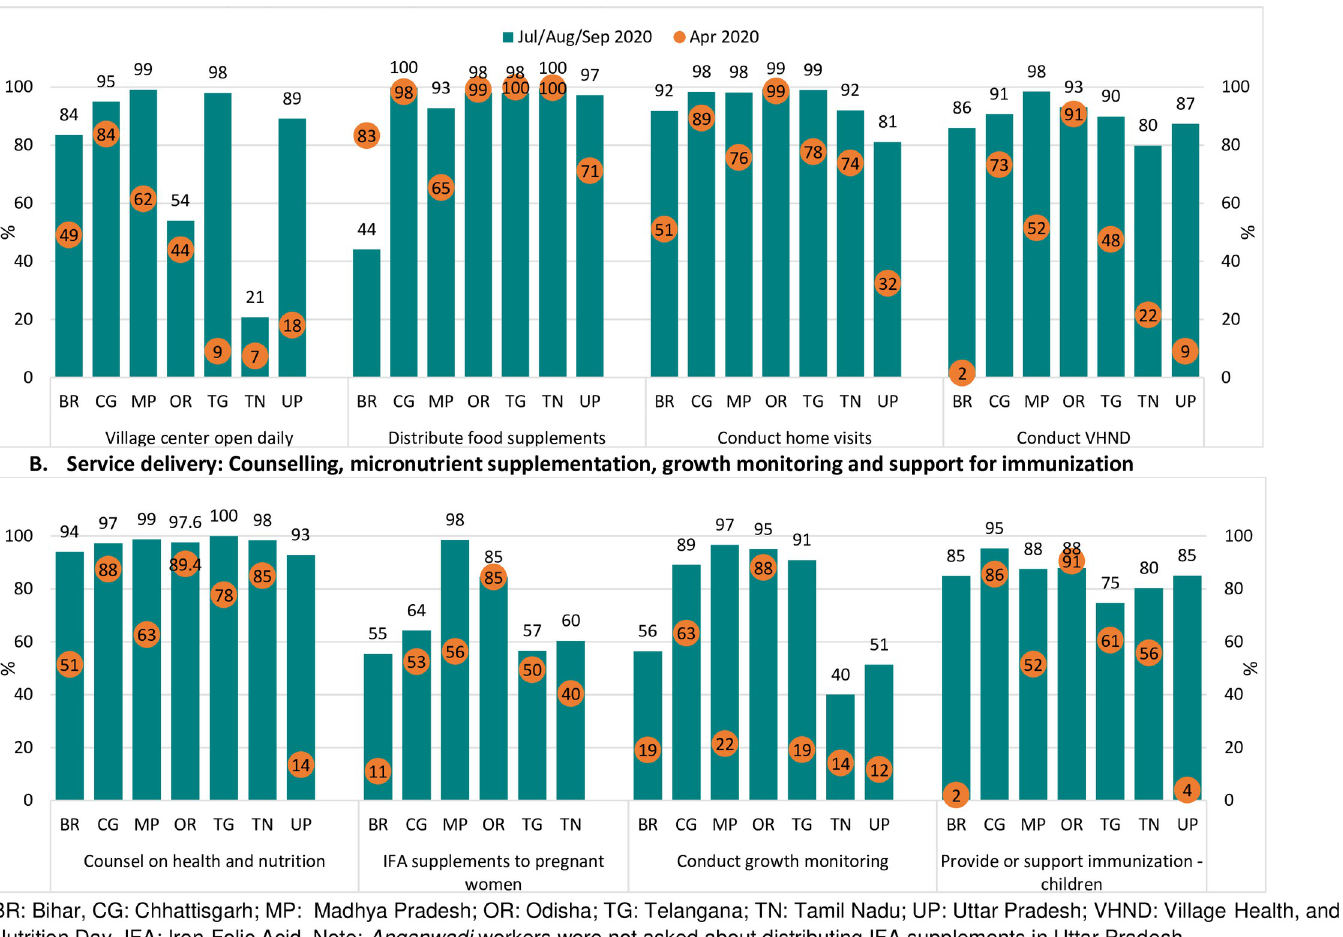
PLOS ONE | https://doi.org/10.1371/journal.pone.0269674 July 27,